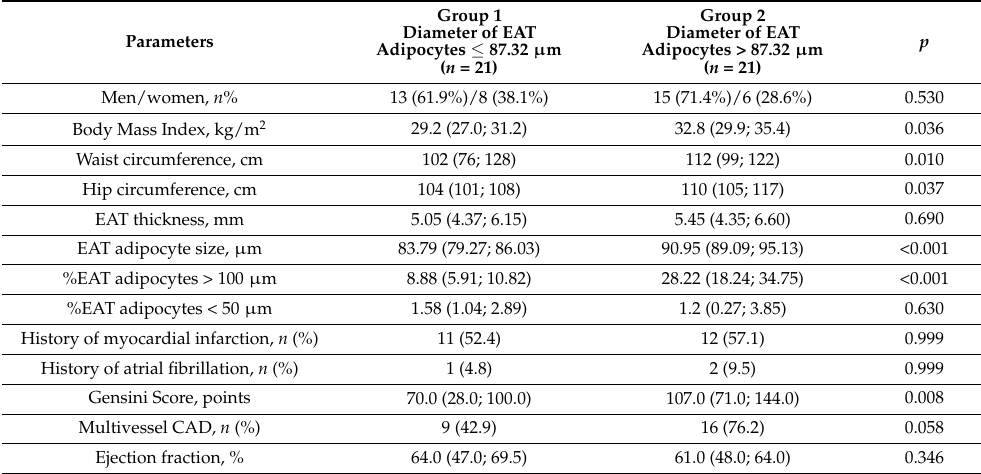
Table 2. Anthropometric characteristics of obesity and morphometric parameters EAT adipocytes depending on the mean size of